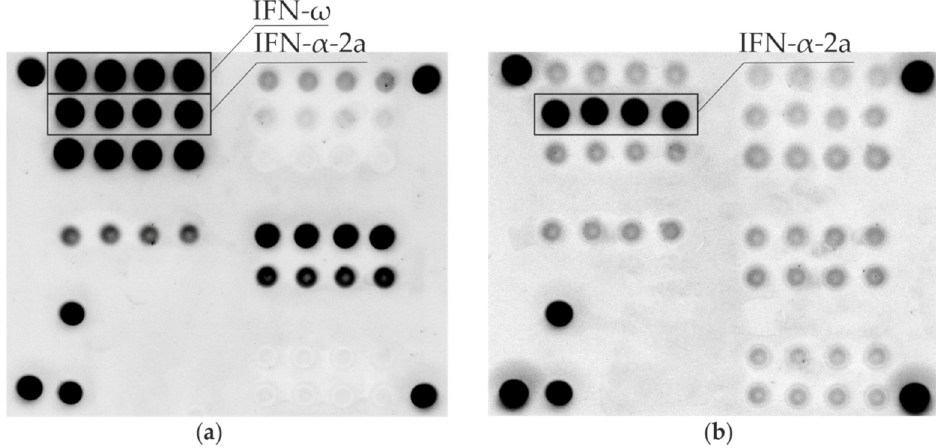
Figure 1. Fluorescence images of microarrays after assay with serum samples from: an APS-1 patient ( a ), a patient with multiple endocrine neoplasia type 1 ( b ). Groups of elements with immobilized omega-interferon (IFN- ω ) and alpha2a-interferon (IFN- α -2a) are indicated by solid lines.